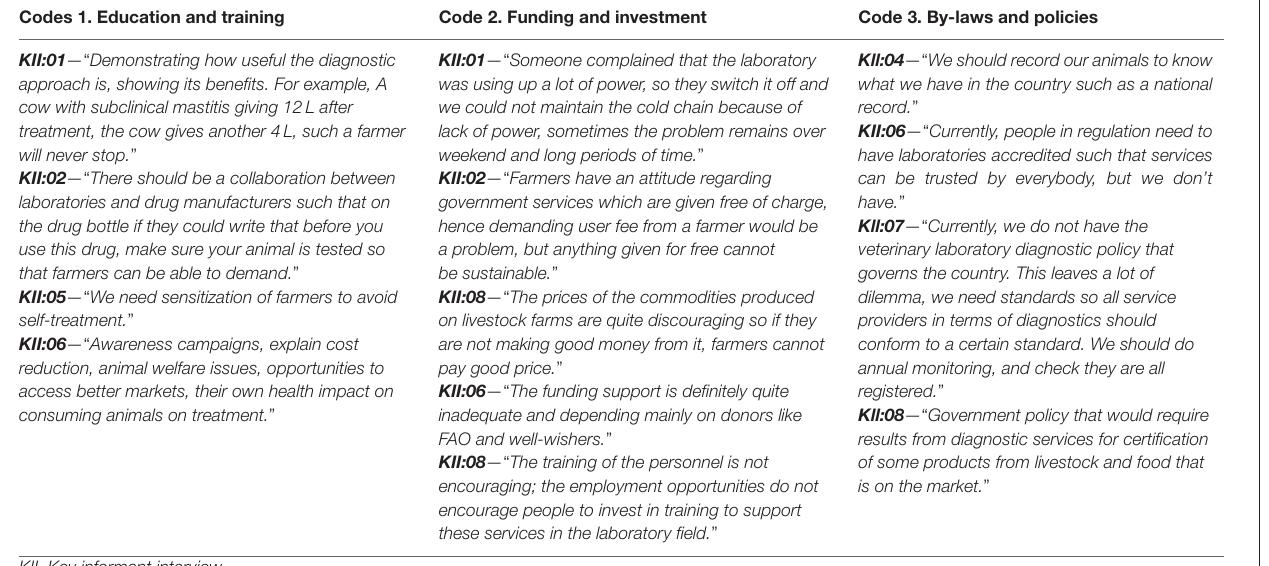
BOX 3 | Solutions and recommendations suggested by key informants for improvements of current and emerging veterinary diagnostic laboratories in